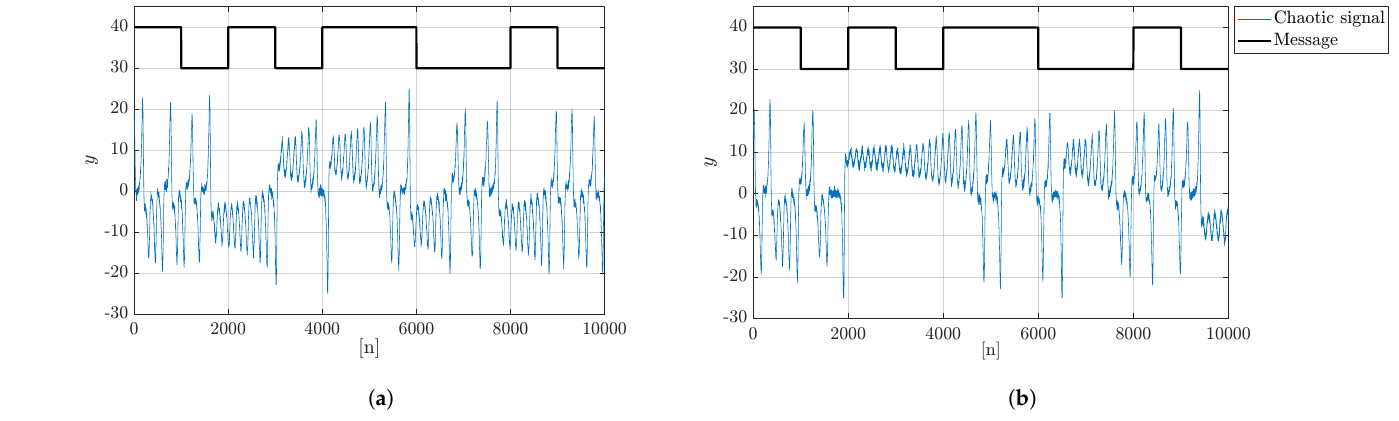
Figure 2. Message transmission using ( a ) PM and ( b ) SCM technique.